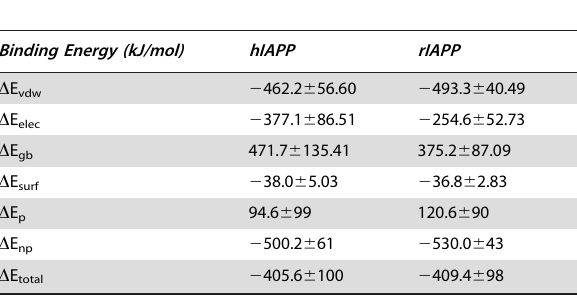
Table 1. Decomposition of the average binding energy of the highest populated tetrameric oligomers for rIAPP and